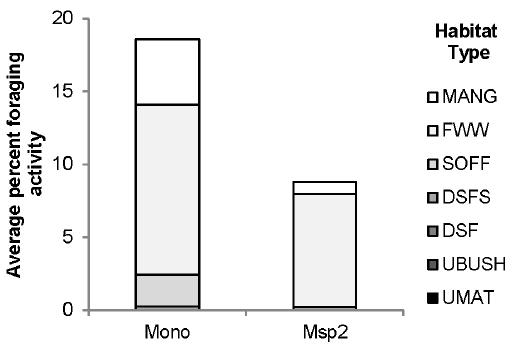
Figure 3. Average percentage foraging activity. Average percentage foraging activity recorded for Mormopterus norfolkensis (Mono) and M. species 2 (Msp2) across seven different habitat types. FWW - freshwater wetland; DSF - dry sclerophyll forest and woodland; DSFS - dry sclerophyll forest and woodland on sand; UBUSH - urban bushland remnant; UMAT - urban matrix; MAN - mangrove forest; and SOFF - swamp oak forest. species (Figure 3). No foraging activity by either species was recorded in the urban habitat types and no M . species 2 foraging activity was recorded in swamp oak forest.